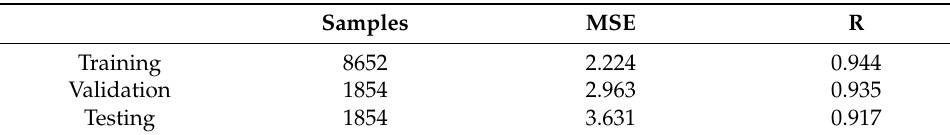
Figure 7. Permutation Feature Importance. Table 8. NN Model summary.